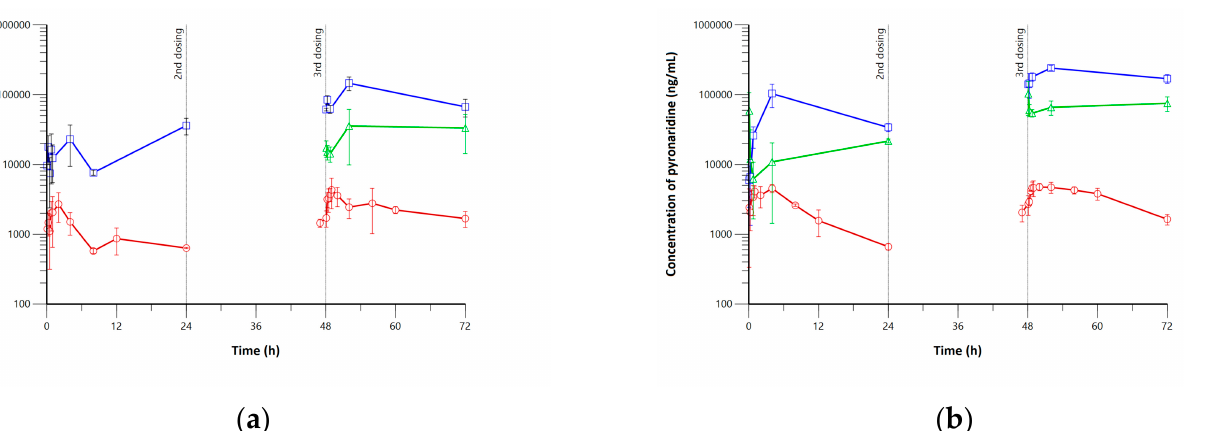
Figure 2. Pharmacokinetic profiles for ( a ) low-dose (180 mg/kg) and ( b ) high-dose (360 mg/kg) groups of pyronaridine in hamsters. Blue squares, green triangles, and red circles with solid lines represent lung, trachea, and blood concentrations of pyronaridine, respectively.